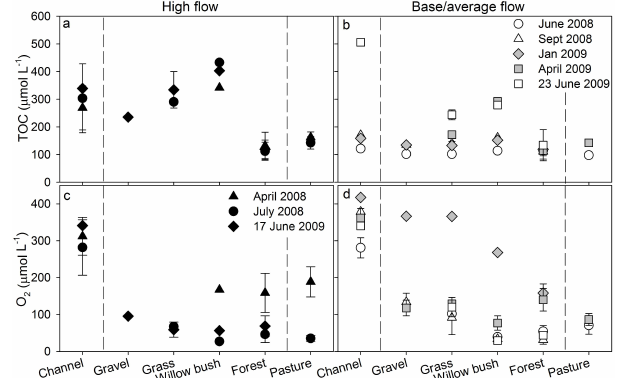
Fig. 8. TOC and O 2 concentrations in different riparian zones dur- ing high discharge (a, c) and base to average discharge of the river Thur (b, d) . Values from piezometers located in the same riparian zone were averaged and error bars represent standard deviations Fig. 6. Rayleigh plots for δ 15 N from June and September 2008 ( n > 2) or average deviations ( n = and 23 June 2009 indicate that 42–94% of the covariance between ln[NO − ] and δ 15 N can be explained by biological fractionation. 3 The slope of the regression lines indicates the apparent (or commu- nity) enrichment factors of NO − removal. 3